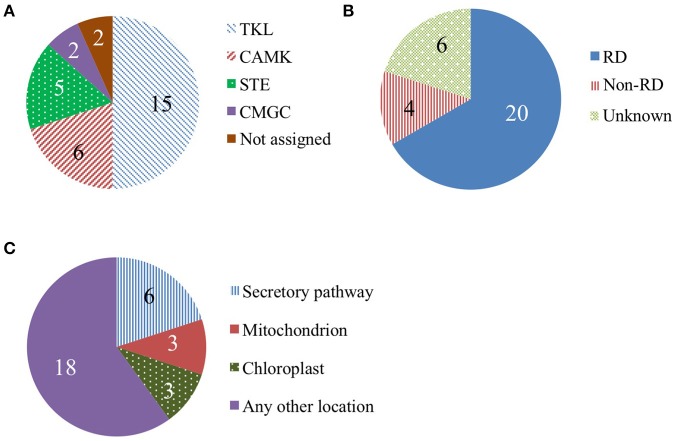
Protein kinases in the rice elongating internode. (A) Kinase phylogenetic groups. The TKL (Tyr kinase-like) group includes mixed lineage kinases, transforming growth factor-β receptor kinases, and Raf kinases. The CAMK group consists of calcium/calmodulin-dependent protein kinases. The STE group includes homologs of yeast sterile 7, sterile 11, and sterile 20 kinases. The CMGC group includes CDK, MAPK, GSK3, and CLK kinases. (B) Kinase categories based on a conserved kinase RD motif. Kinases containing this motif are RD kinases while non-RD kinases lack the motif. (C) Predicted subcellular localization of kinases.